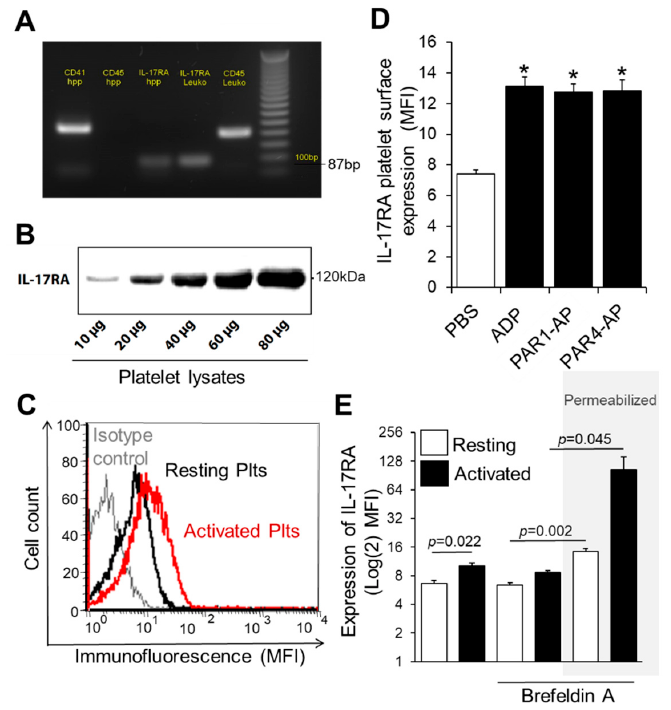
Figure 1. Expression of IL-17RA on platelet surface is increased in activated platelets. ( A ) Total RNA was isolated from highly purified platelets and reverse transcribed into cDNA. The cDNA was amplified with primers specific for IL-17RA (87-bp product). Additionally, amplification of CD41 and CD45 mRNA was used as quality control of samples. A 100-bp DNA ladder is shown on the left lane. ( B ) Western blotting analyses of IL-17RA. The presence of IL-17RA was confirmed in lysates from resting platelets. ( C ) A representative overlay histogram for IL-17RA expression in washed platelets. Human washed platelets were activated with ADP (red line) or PBS (resting platelets, black line) and stained with a monoclonal antihuman anti-IL-17RA antibody (PE-anti-IL- 17RA; red line) or with control isotype antibody (PE-conjugated IgG 1 ) (grey line). ( D ) Platelet-rich plasma (PRP) was stimulated with ADP (50 μΜ ), TRAP14 (50 μΜ ), PAR4-AP (100 μΜ ) or PBS for 10 min at room temperature. Platelet suspension was then stained with PE-anti-IL-17RA or with PE- conjugated IgG 1 and analysed with flow cytometry. Values are shown as Mean MFI ± SEM of three independent experiments (* p < 0.05 vs. PBS). With regard to statistics, p -value is <0.05 for all comparisons indicated as determined by one-way ANOVA followed by Dunnett’s multiple comparison test. ( E ) Washed platelets were activated with PAR4-AP (100 μ M) or PBS in the presence or absence of Brefeldin A (BFA; 20 μ g/mL), an inhibitor of protein transport, and labelled with PE-